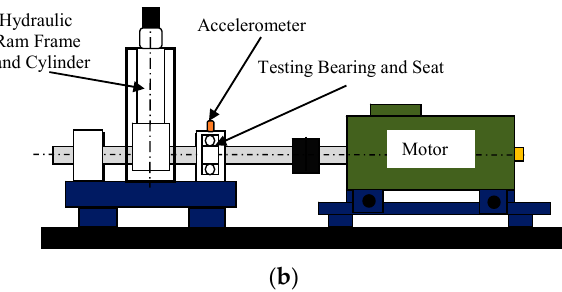
Figure 8. Experimental setup: ( a ) illustrative diagram; and ( b ) schematic drawing [18].